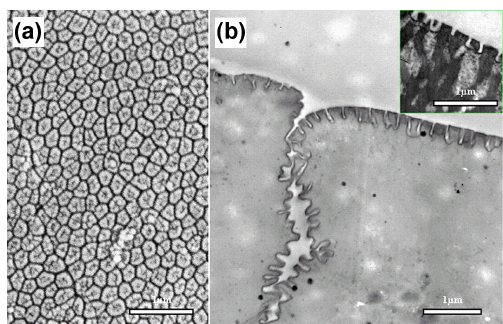
Figure 17. Nanostructural features of the frog toe pad. ( a ) High resolution scanning electron microscopy (SEM) image of a large number of hexagonal nanostructures forming an array on the external surface of the epithelial cell; ( b ) High resolution transmission electron microscopy (TEM) image of one of the channels that separates adjacent epithelial cells along with the side view of nanostructures, which themselves are separated by even narrower channels. The inset shows similar nanostructures on the toe pad of the hylid tree frog Scinax rubber [81]. Reproduced with permission from The Journal of Experimental